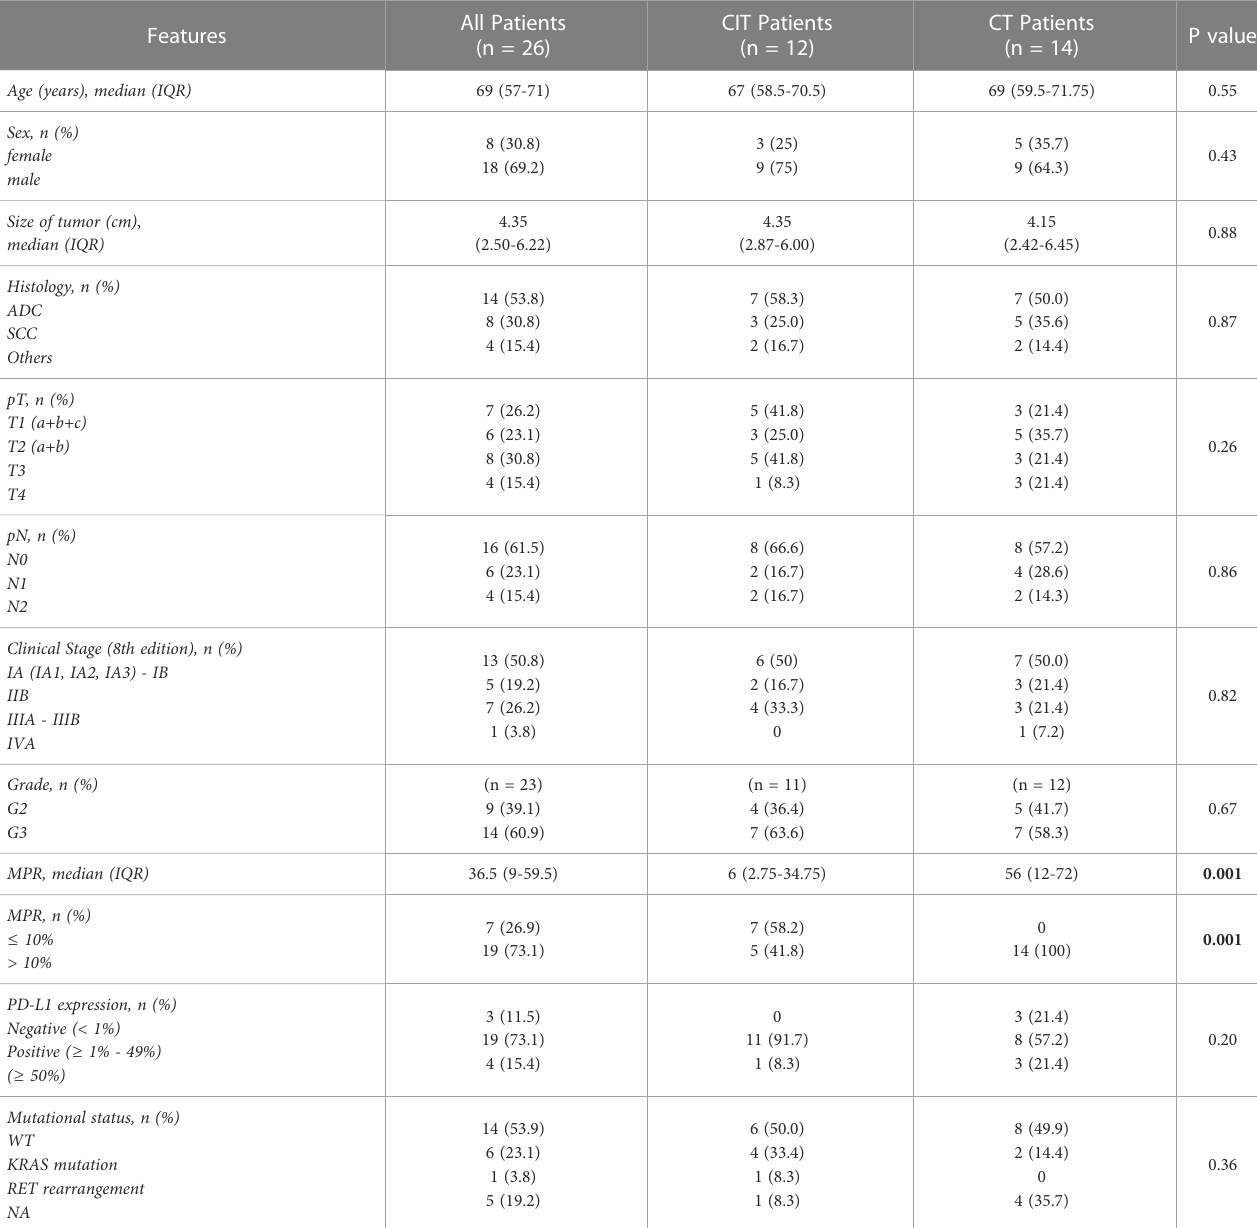
TABLE 1 Clinicopathological characteristics and pathological response of NSCLC patients according to treatment regimens.